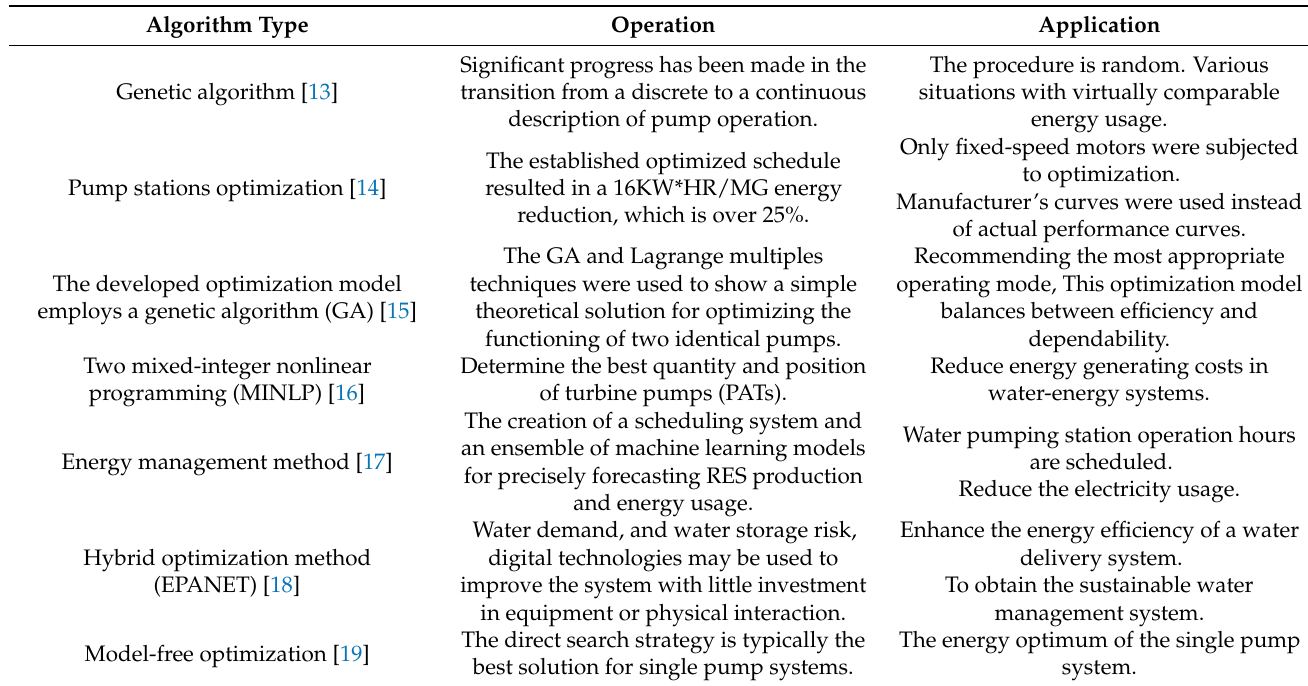
Table 1. Different types of pump optimization algorithms with